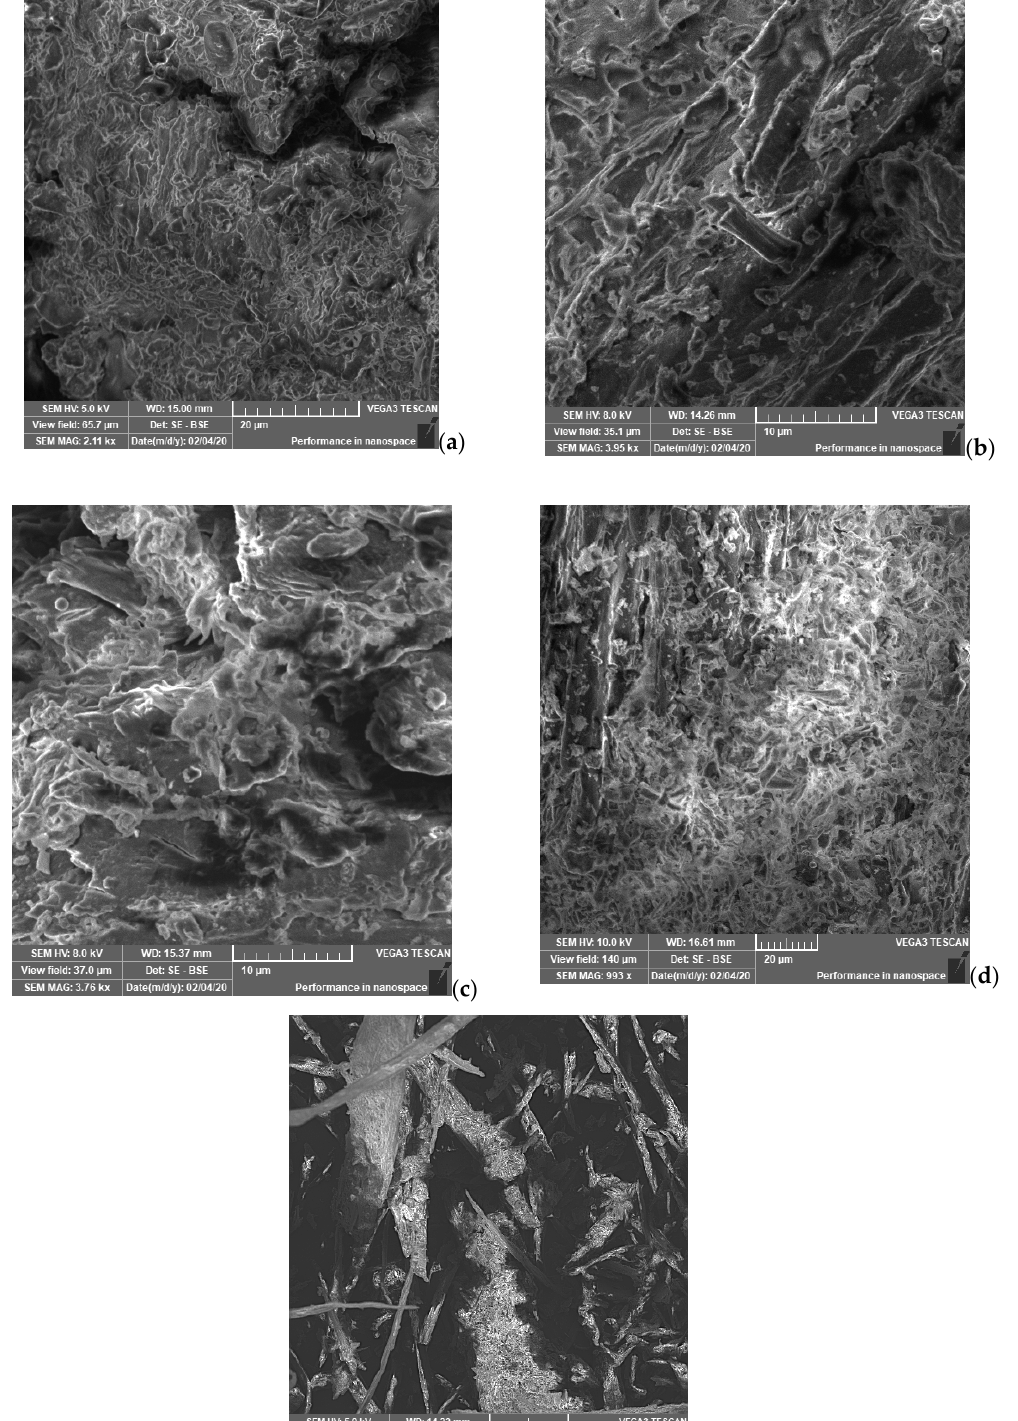
Figure6. Scanningelectronmicroscopyimagesofthesamples(vine-shootwasteofBusuioacadeBohotin Figure 6. Scanning electron microscopy images of the samples (vine-shoot waste of Busuioaca de variety): ( a ) untreated, ( b ) autohydrolysed at 150 ◦ C, ( c ) autohydrolysed at 165 ◦ C, ( d ) autohydrolysed Bohotin variety): ( a ) untreated, ( b ) autohydrolysed at 150 °C, ( c ) autohydrolysed at 165 °C, ( d ) at 180 ◦ C, ( e ) autohydrolysed at 180 °C, ( e ) delignified.